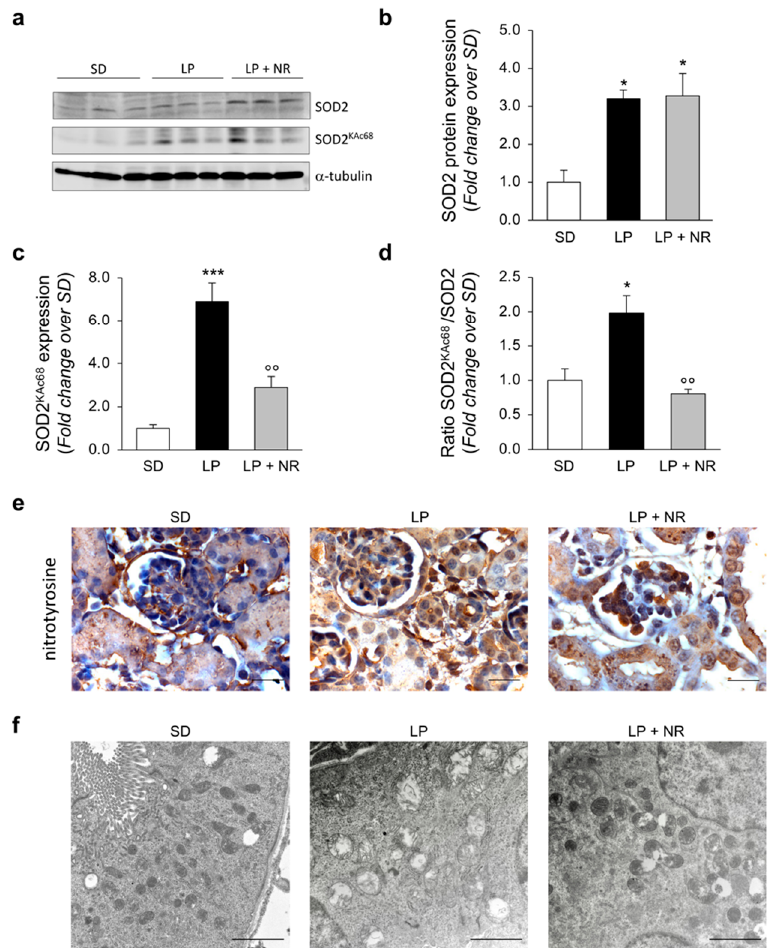
Figure 5. NR supplementation protects from oxidative stress by regulating SOD2 in maternal LP diet offspring, preserving mitochondrial ultrastructure. ( a – c ) Representative Western blots ( a ) and densitometric analysis of total SOD2 ( b ) and SOD2 acetylated at lysine 68 (SOD2 KAc68 ) ( c ) in total kidney extracts harvested from newborn mice (day 1) from mothers fed a SD, LP diet alone or with NR; n = 3 samples per group. Each sample consisted of a pool of at least 4 kidneys from 4 newborn mice. ( d ) Densitometric analysis of SOD2 acetylation expressed as the ratio between the expression of SOD2 KAc68 and total SOD2 in total kidney extracts harvested from newborn mice (day 1) from mothers fed a SD, LP diet alone or with NR; n = 3 samples per group. Each sample consisted of a pool of at least 4 kidneys from 4 newborn mice. ( e ) Representative images of nitrotyrosine signal in renal tissues from offspring from mothers fed a SD, LP diet alone or with NR. Scale bars, 20 µ m. ( f ) Representative micrographs of mitochondrial alterations in proximal tubular cells of newborn mice (day 1) from mothers fed SD, LP diet alone or with NR; n = 3 kidneys from 3 newborn mice. Scale bars, 2000 nm. Results are presented as mean ± SEM and were analyzed with ANOVA with Tukey’s post hoc test; * p < 0.05, *** p < 0.001 vs. SD and °° p < 0.01 vs. LP.